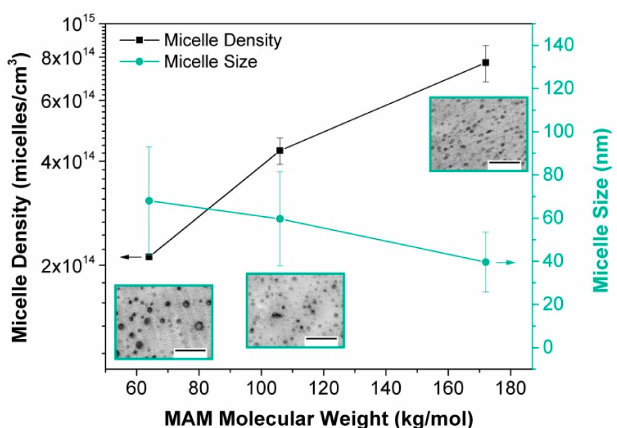
Figure 6. Micelle density (left axis) and micelle size (right axis) of PMMA/MAM blends as a function of the MAM molecular weight. TEM images of the blends (scale bar: 500 nm).